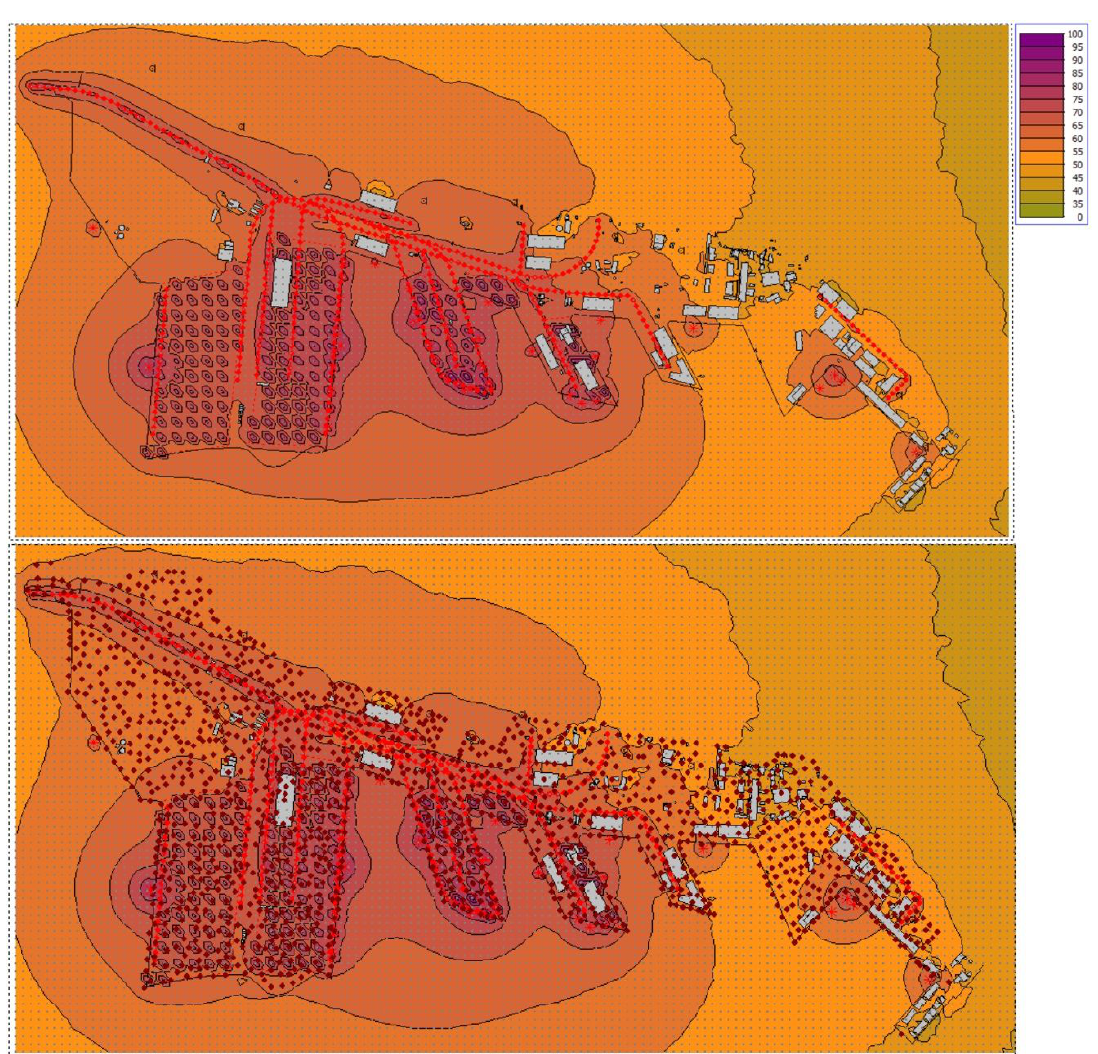
Figure 2: Comparison of results without (above) and with (below) height points Table 1: Comparison of the simulated noise levels with and without height points